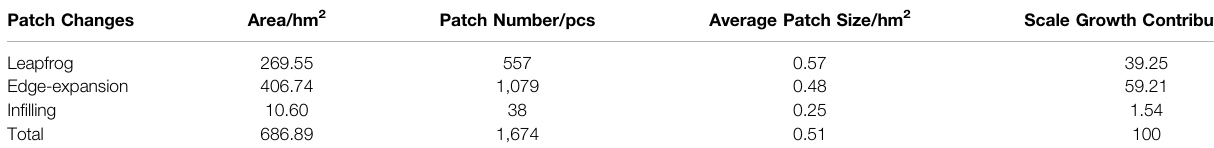
TABLE 4 | Areas and numbers of different changing RRL patches in Pinggu from 2005 to 2015.